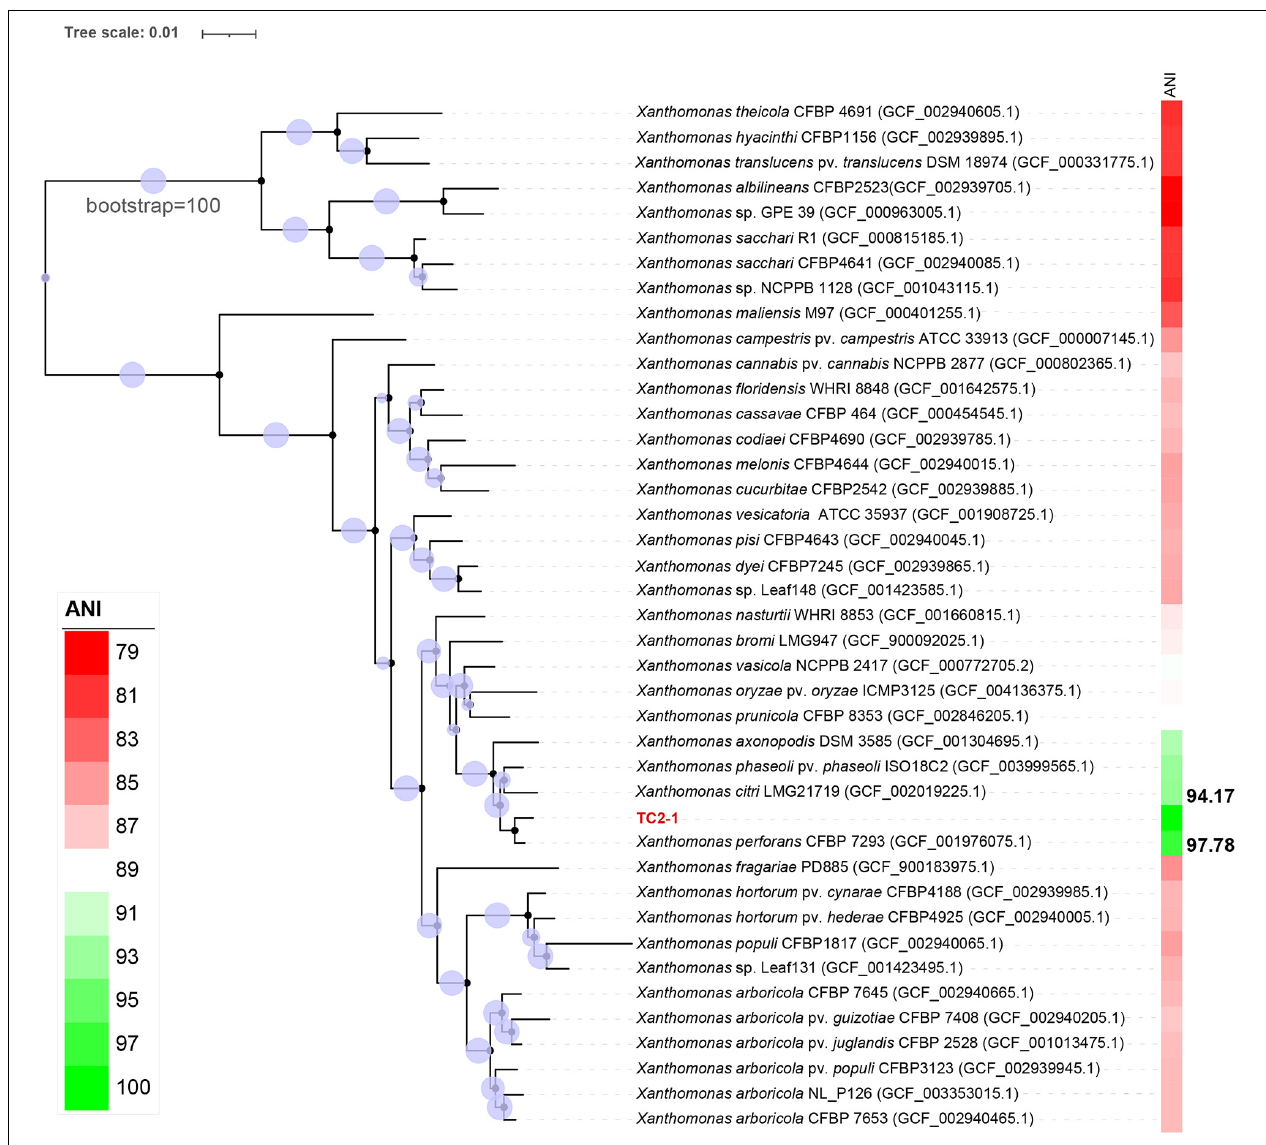
FIGURE 6 | Phylogenetic tree of strain TC2-1 and the representative strains in genus Xanthomonas listed in the GTDB. ANI analysis was used by means of GTDB-Tk (Chaumeil et al., 2020). The closest strain of TC2-1 is X. perforans CFBP 7293 with a 97.78% ANI value.